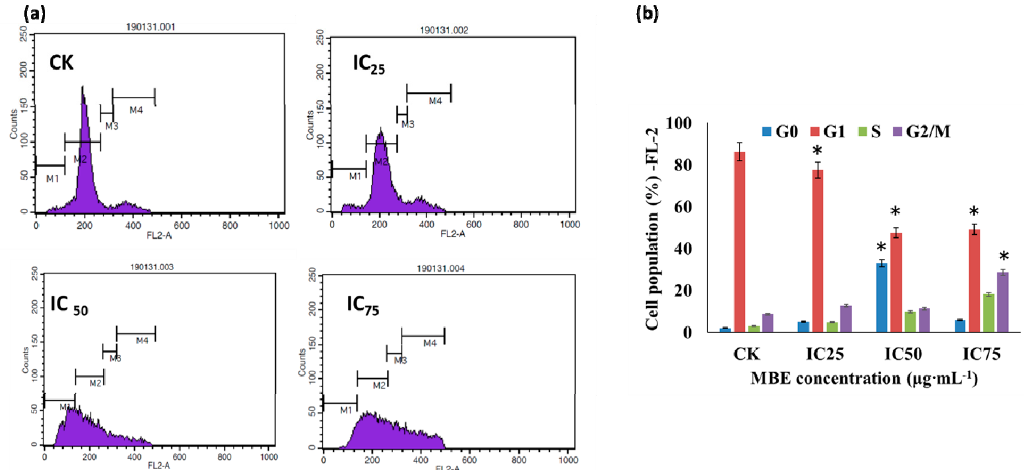
Figure 4. ( a ) Arrested the cell cycle of the human lung carcinoma A549 cells by the MBE treatments. Distribution of the cell cycle as determined by propodium iodide staining after the treatment of various concentrations of MBE. ( b ) Proportion of cells per cell phase in cell cycle. Data are as mean ± standard error (SEM, n = 3). * p < 0.05; M1—G0; M2—G1; M3—S and M4—G2/M.